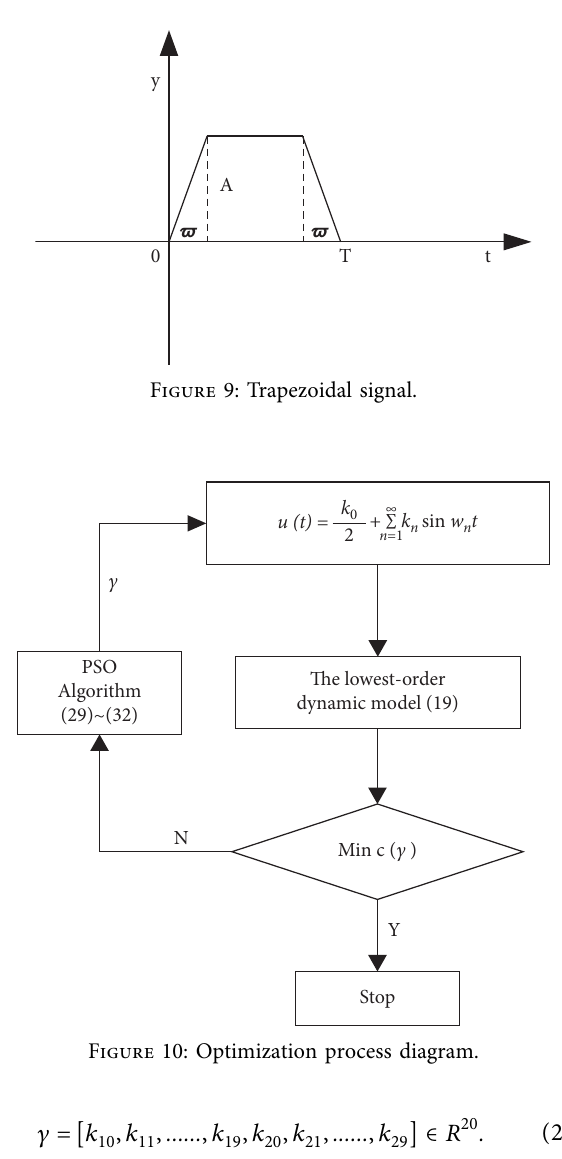
Figure 10: Optimization process